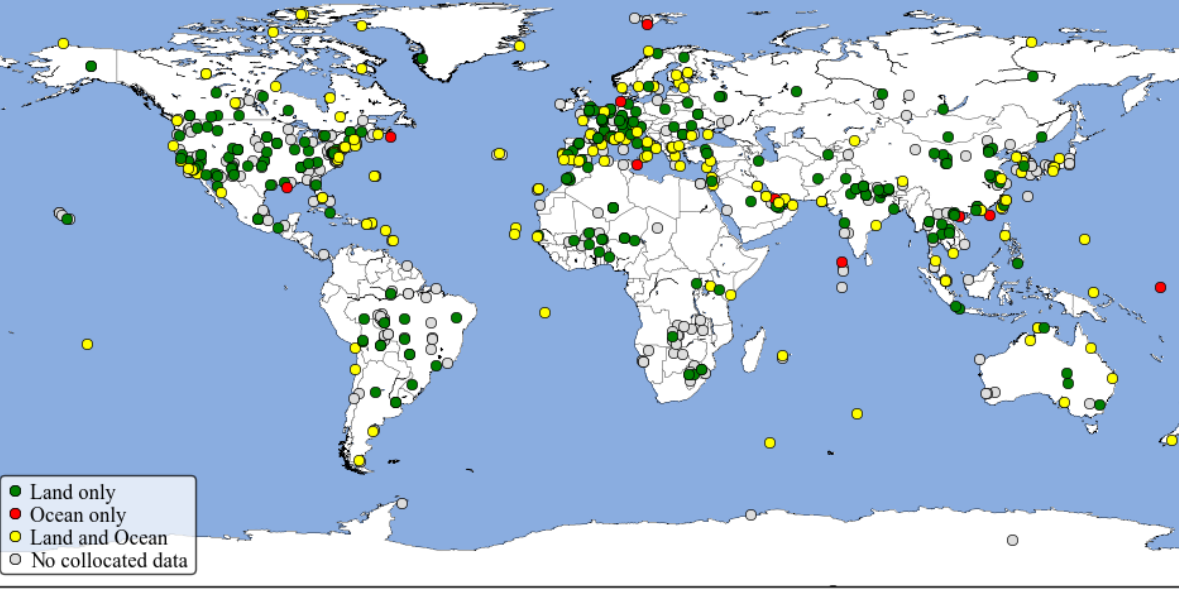
Figure 2. Distribution of AERONET stations used in the study. Green, red, and yellow colors indicate stations that can be classified as land only (233 sites), ocean only (11 sites), or both land and ocean (149 sites), respectively. The classification was established based on data availability in separate over-land and over-ocean datasets in MODIS, SeaWiFS, and POLDER aerosol products. Gray color indicates stations that do not have any collocated data for the studied period of time.